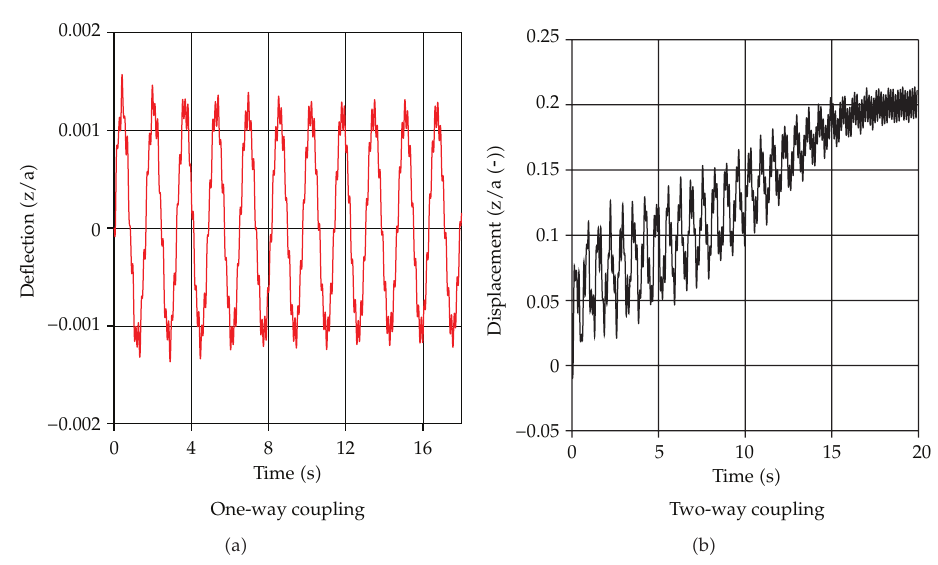
Figure 13: Displacement over time, v (cid:8) 0 . 64m/s, plate 2.